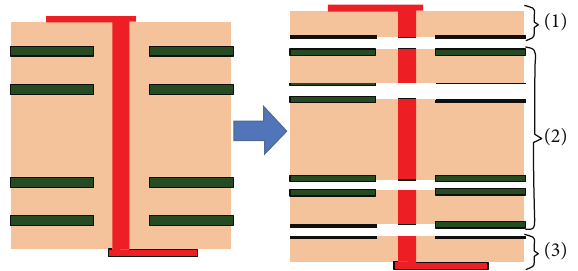
Figure 5: Diagram of single via structure